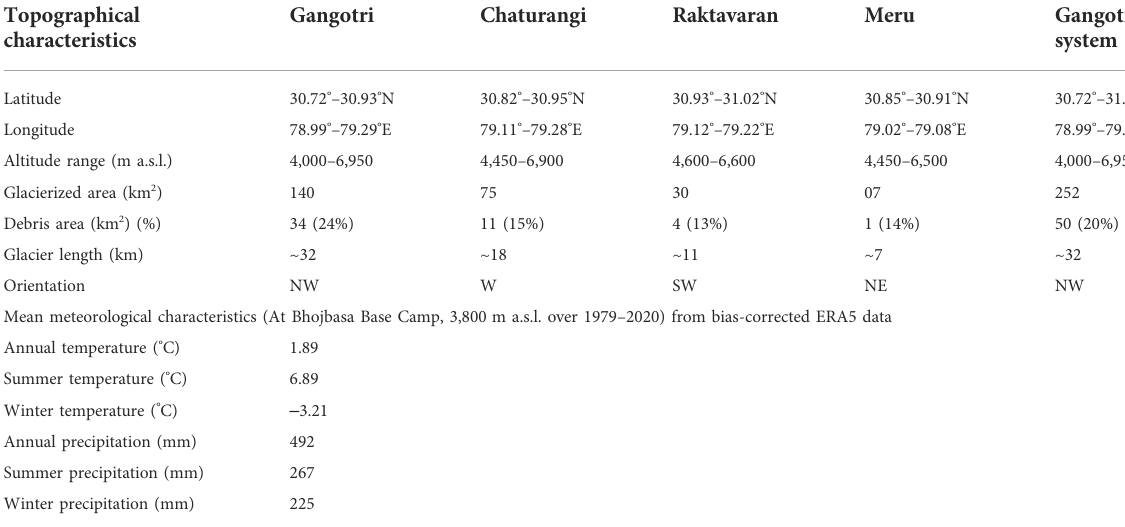
TABLE 1 Topographical and meteorological characteristics of the Gangotri Glacier